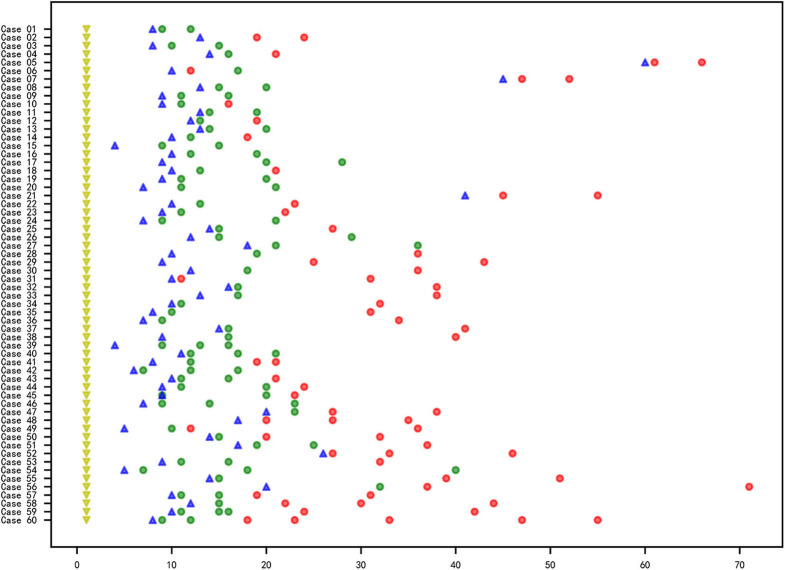
Information of the RMPP course, sample collection and M. pneumoniae culture of the 60 cases. X axis represented for the day and the Y axis represented for the case No. The yellow triangle (): first onset of disease; blue triangle (): time point for the admission to Beijing Children's Hospital affiliated to Capital Medical University; circle: collection time point for the BALF samples; red circle (): negative for M. pneumoniae culture; green circle () positive for M. pneumoniae culture.